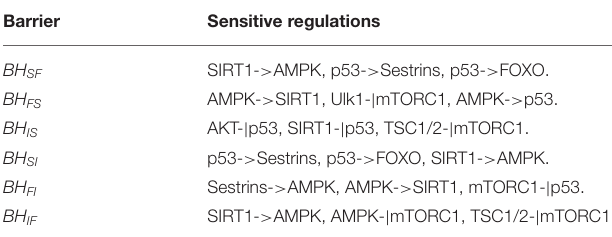
TABLE 1 | Top three key regulations from global sensitivity analysis. Barrier